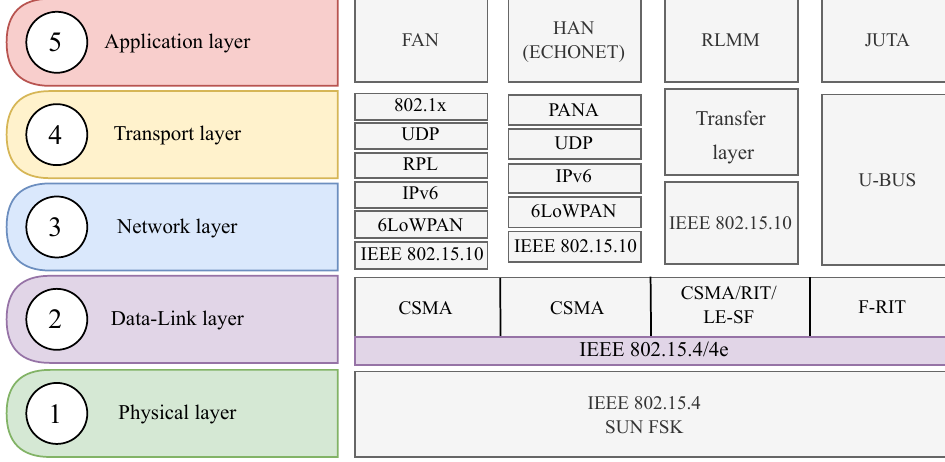
Figure 11. Comparing Wi-SUN different profiles with OSI